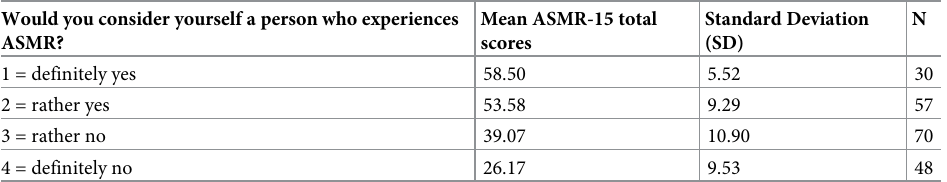
Table 3. Differences in ASMR-15 total scores for self assessed ASMR-responders and ASMR-non-responders. Would you consider yourself a person who experiences ASMR?